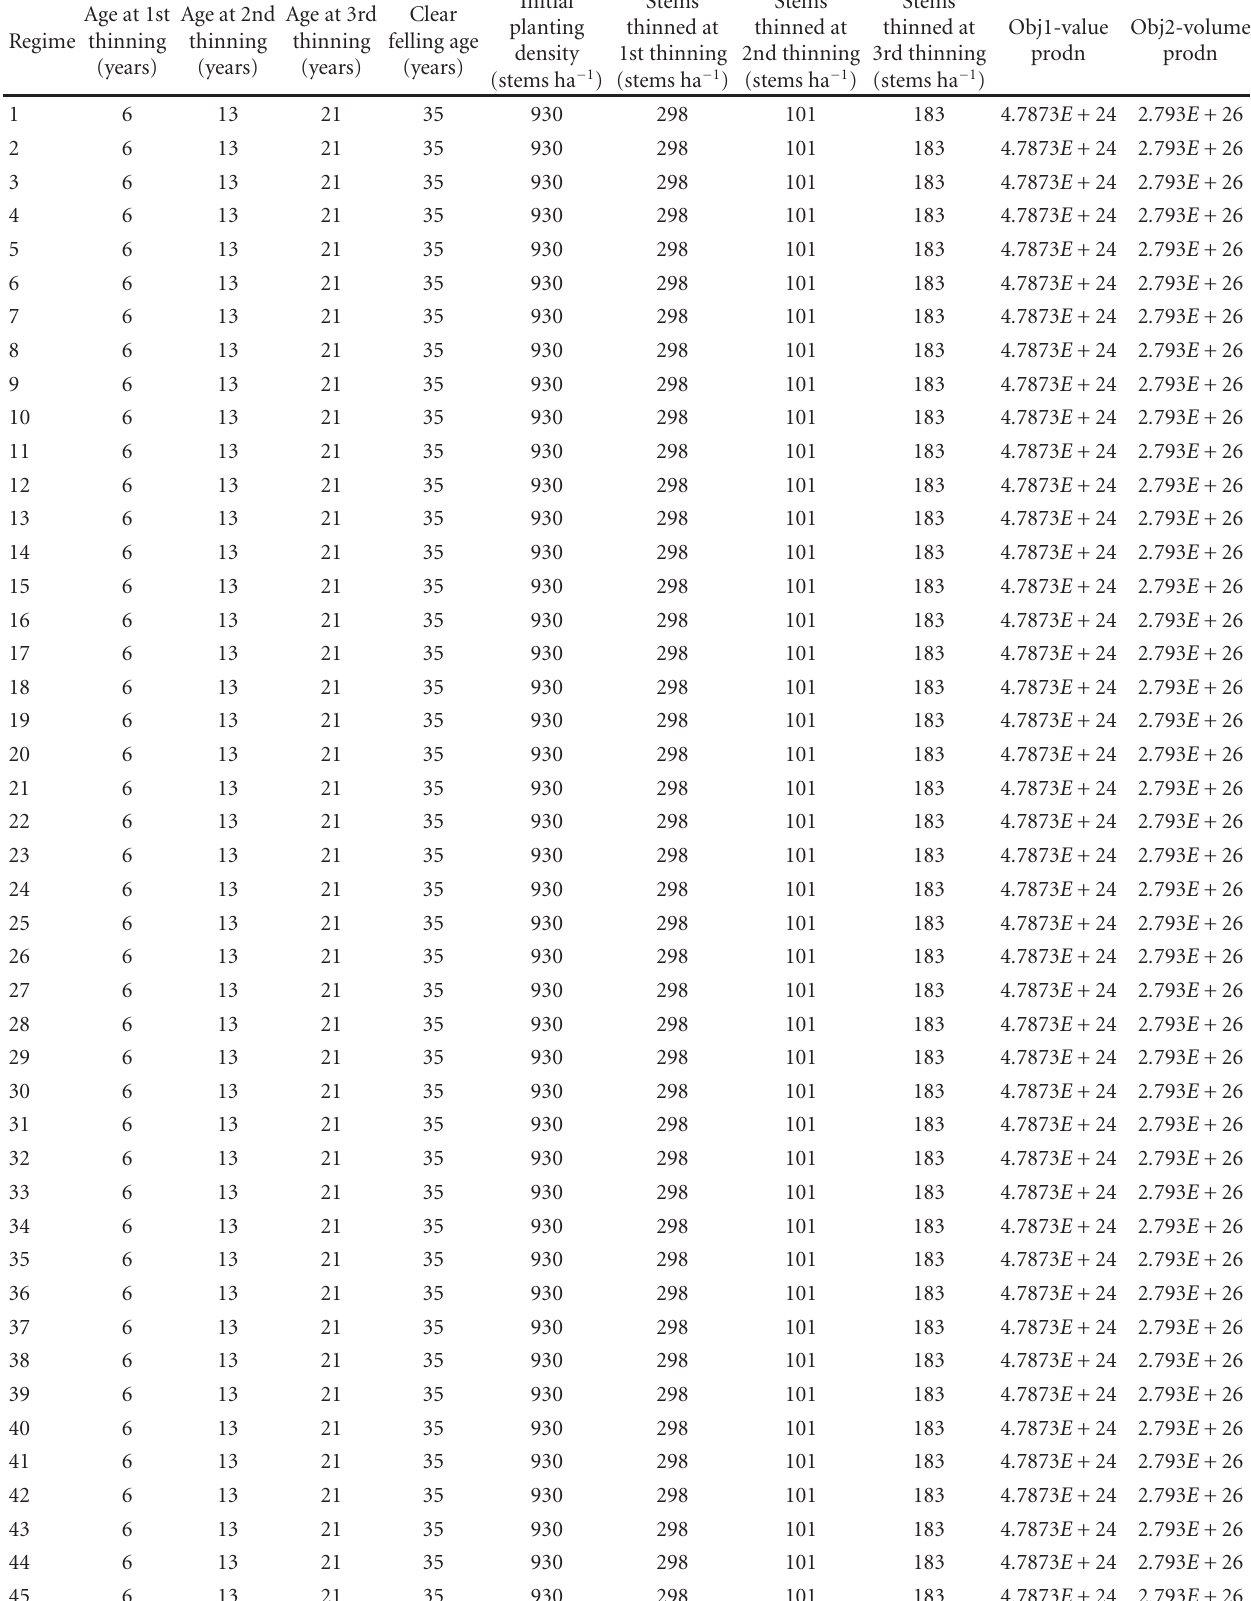
Table 6: A Pareto set estimated using